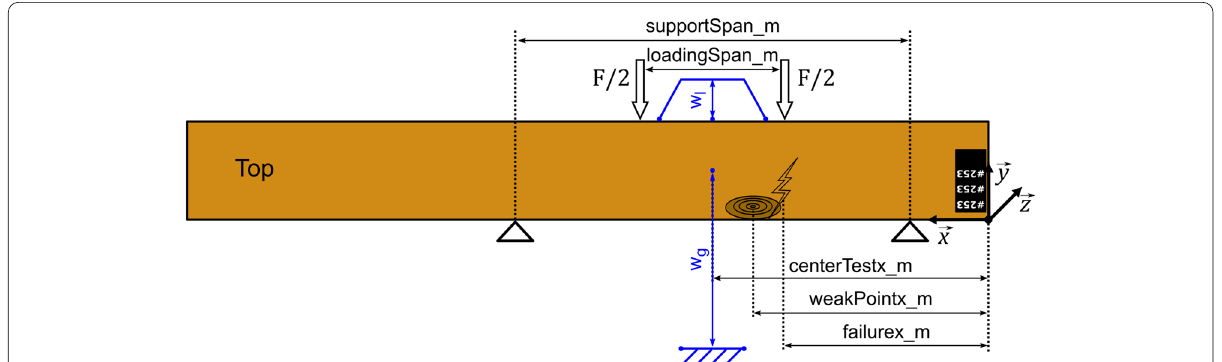
Fig. 12 Bending test scheme with the different variables given in the board‑level data